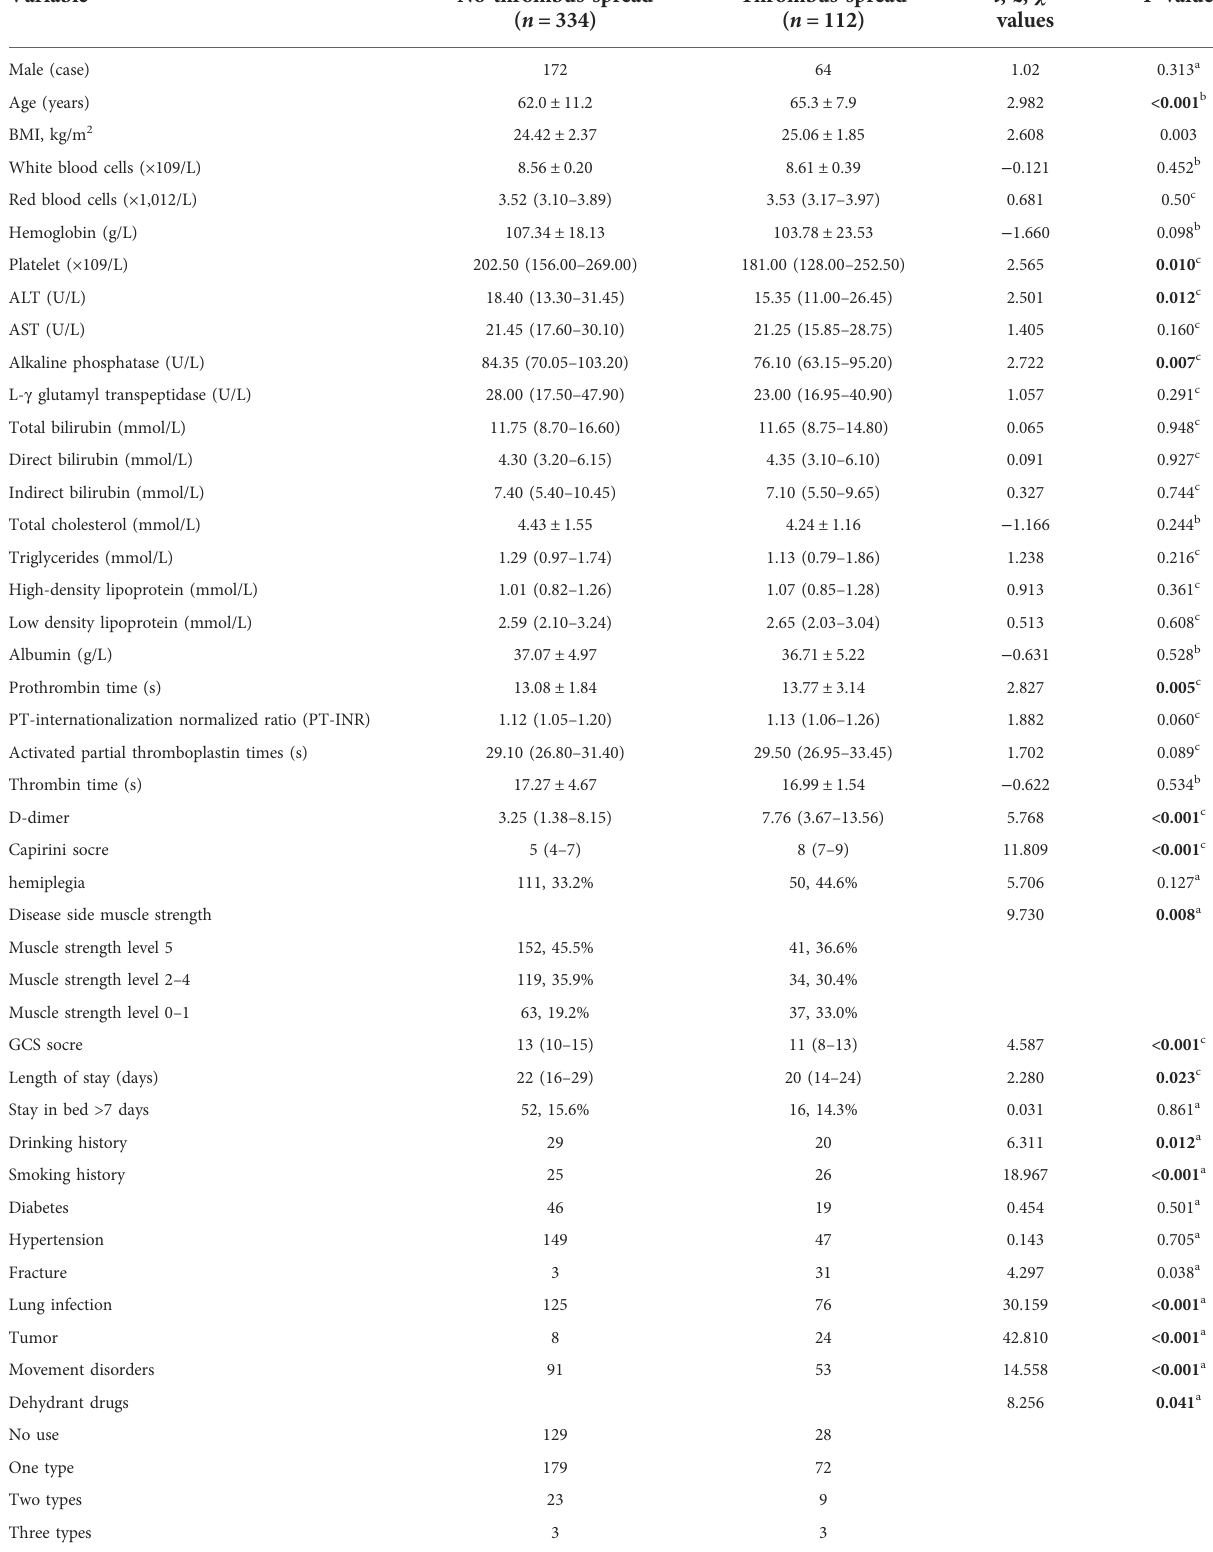
TABLE 1 Univariate